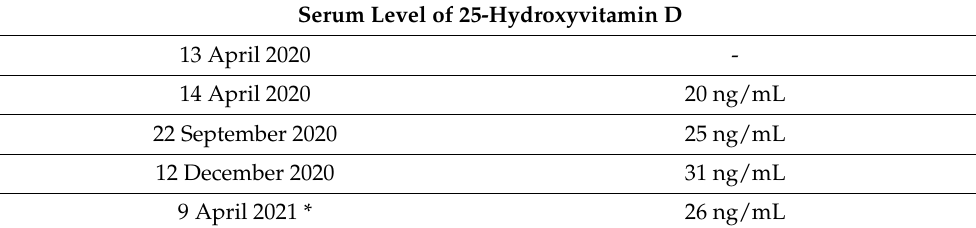
Table 2. Serum level of 25-hydroxyvitamin